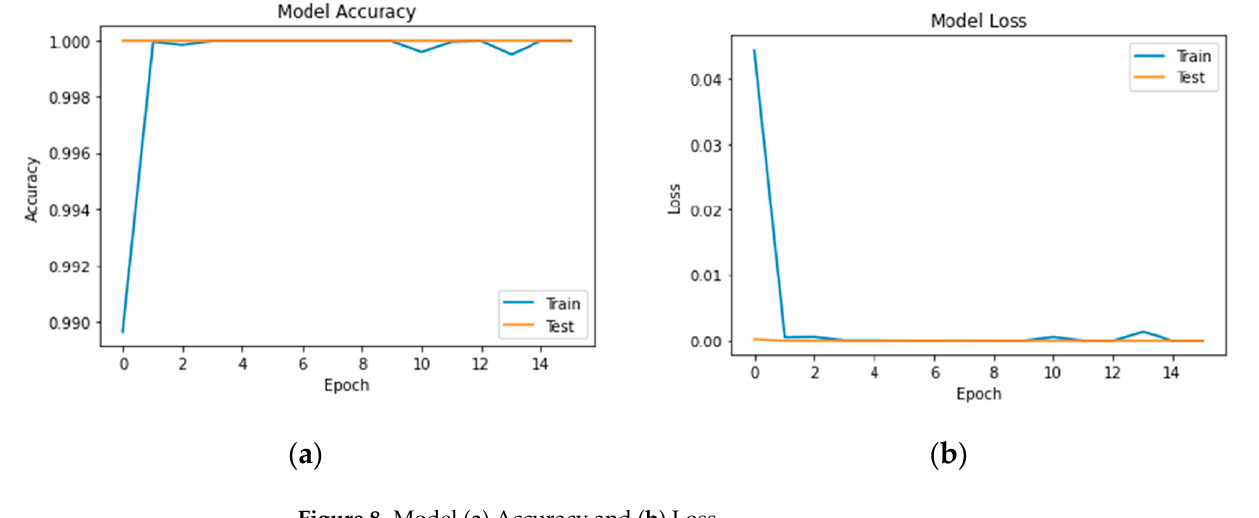
Figure 8. Model ( a ) Accuracy and ( b ) Loss.